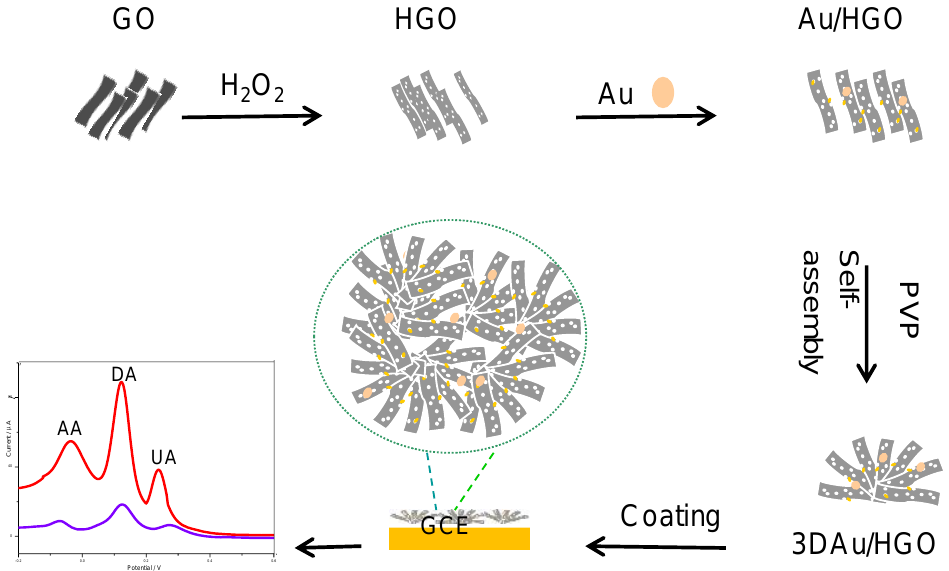
Scheme 1. Schematic representation for the preparation of three-dimensional (3D) Au/holey-graphene oxide (Au/HGO)/glass carbon electrode (GCE) biosensor for simultaneous detection of ascorbic acid (AA), dopamine (DA), and uric acid (UA). PVP: polyvinyl pyrrolidone.